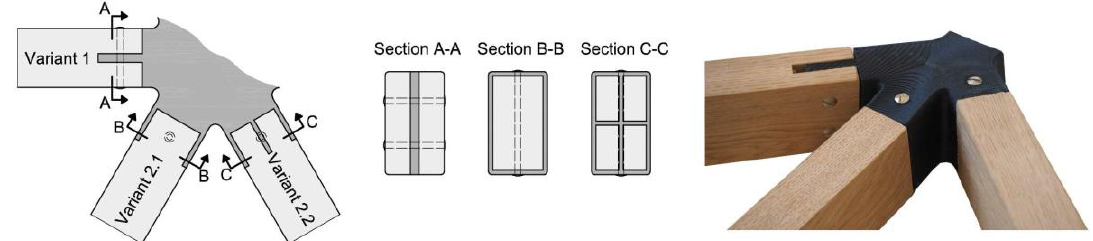
Figure 2. The three different variants for the connection between knot and frame member.